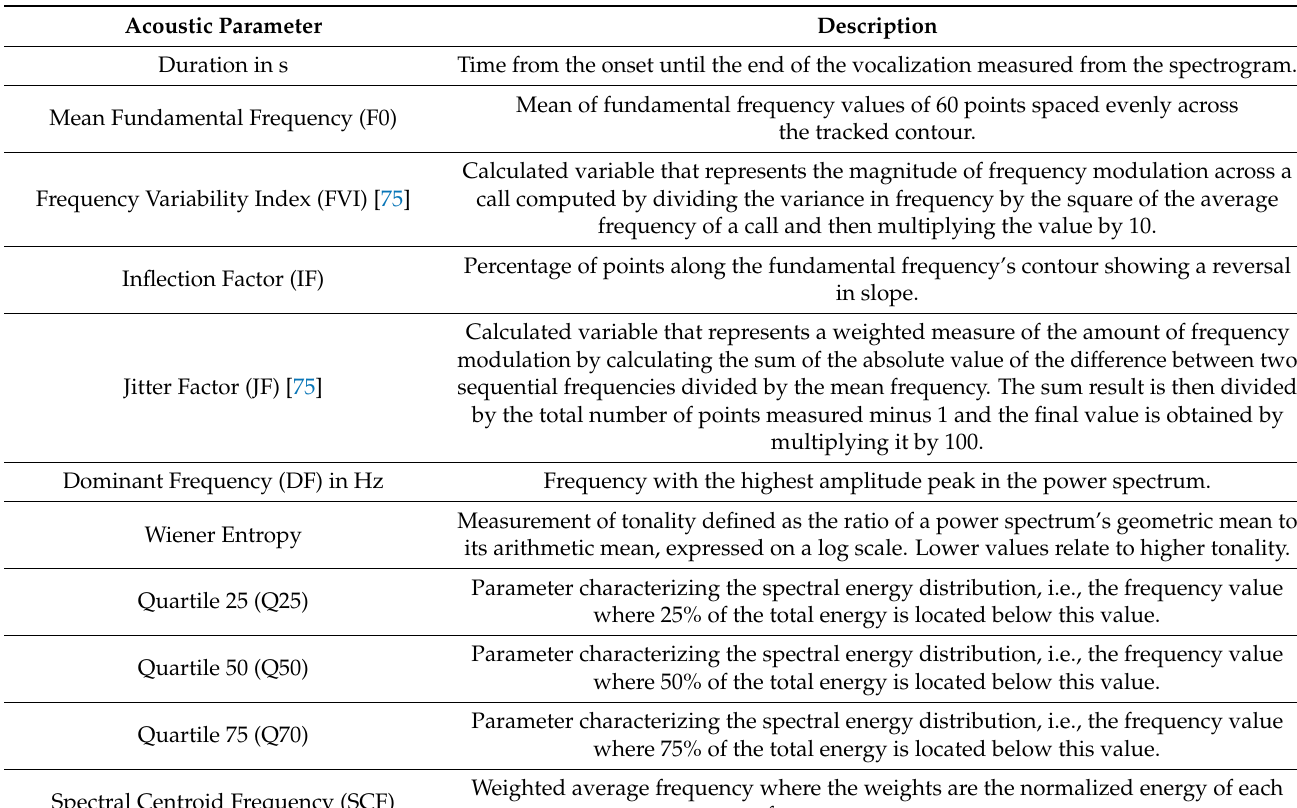
Table 2. Acoustic parameters measured and their